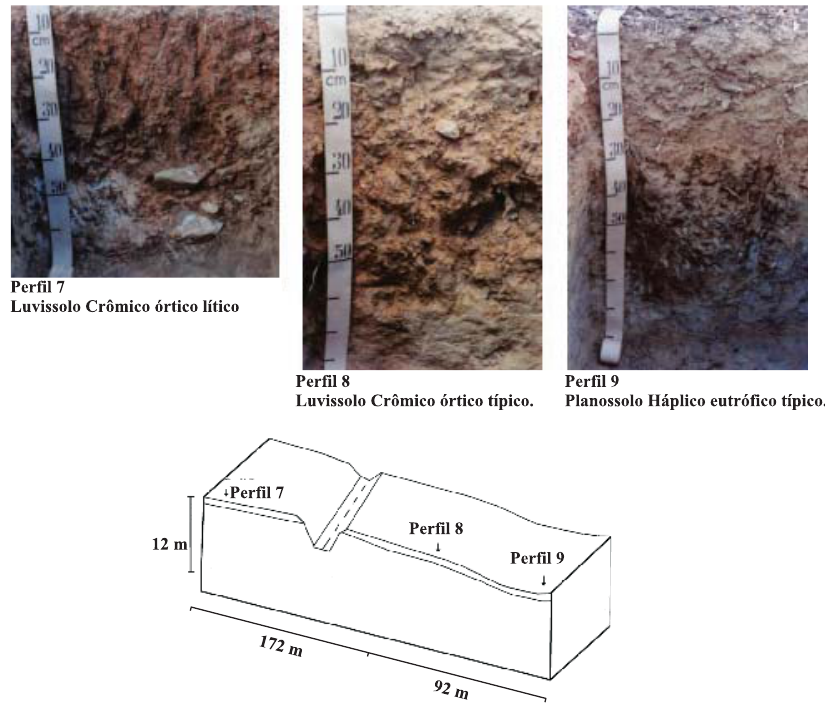
Figura 3. Representação esquemática da localização dos perfis ao longo da sequência e fotografias dos perfis de solo da topossequência